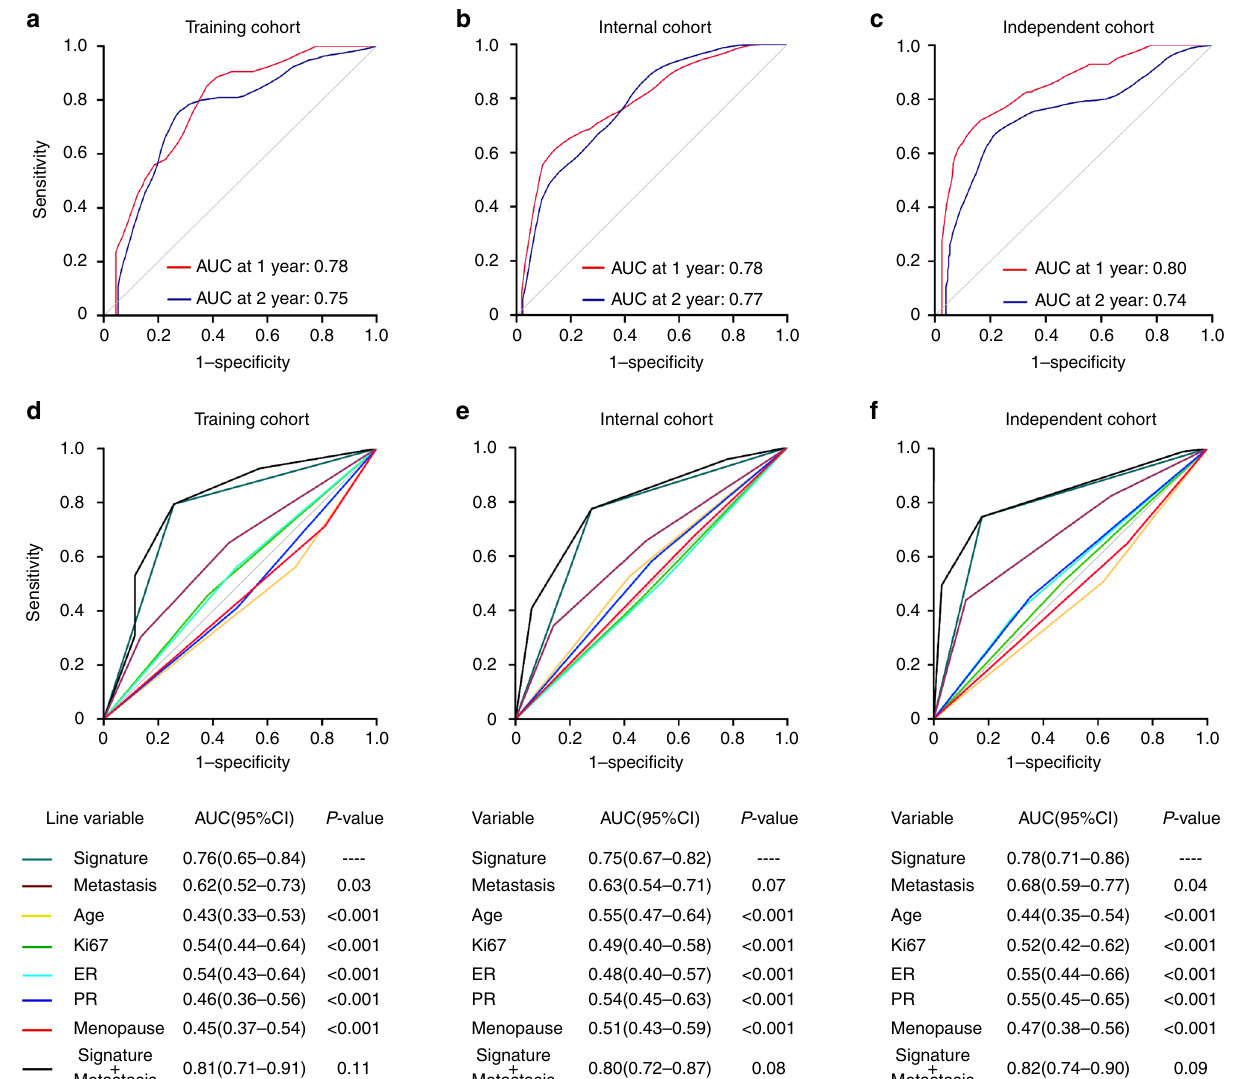
Fig. 4 Receiver operating characteristic (ROC) curves and area under curve (AUC) values. a – c Time-dependent ROC curve in the training cohort, internal cohort, and independent cohort to assess prognostic accuracy; AUC at 1- and 2-year were calculated in the three cohorts according to the 4-miRNA signature, the spanning parameter of the NNE approach was span = 0.25× n obs − 0.20 . d – f Comparisons of the prognostic accuracy for trastuzumab response by the 4-miRNA signature (high score vs low score), metastatic sites (1, 2, ≥ 3), age ( ≤ 50 vs >50), Ki67 (>15% vs ≤ 15%), ER status (positive vs negative), PR status (positive vs negative), menopause (yes vs no), and 4-miRNA signature combining metastatic site. P -values showed the AUC of 4-miRNA signature vs the AUC of metastatic sites, age, Ki67, ER status, PR status, or menopause. AUC was calculated, and its 95% CI was estimated using Bootstrap method. The P -values were two-sided and based on Bootstrap test. ER estrogen receptor, PR progesterone receptor, HR hazard ratio, 95%